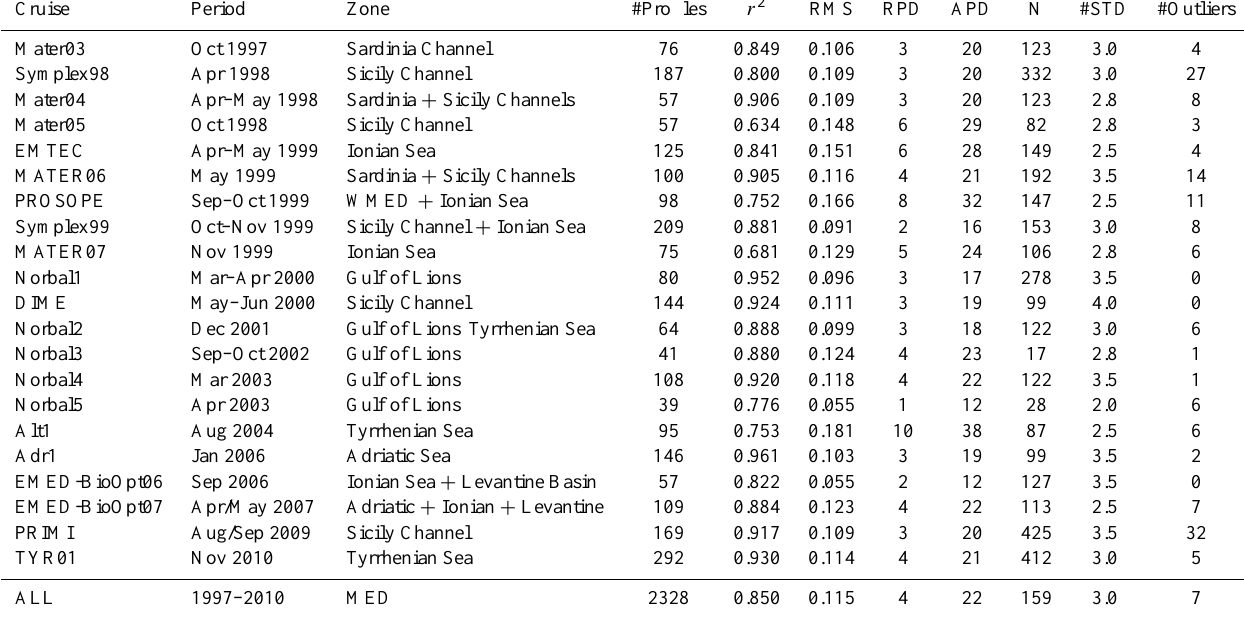
Table 3. List of cruises carried out in the Mediterranean Sea from 1997 to 2010. For each cruise, the total number of calibrated-CHL profiles is reported along with the basic statistics associated with the calibration analysis (see text for details). N represents the total number of bottle-derived fluorescence and HPLC-derived CHL pairs. The number of standard deviation (STD) for the iteratively outlier removal is also indicated. Data from DINA permanent station in the Gulf of Naples, Italy (11 profiles from March to August 2001), are not included in the table as no calibration activity was performed. PROSOPE data were downloaded from http://seabass.gsfc.nasa.gov/seabasscgi/archive index. cgi/NASA GSFC/french. The last row gives the total number of profiles and the average basic statistics. See also Fig. 2.